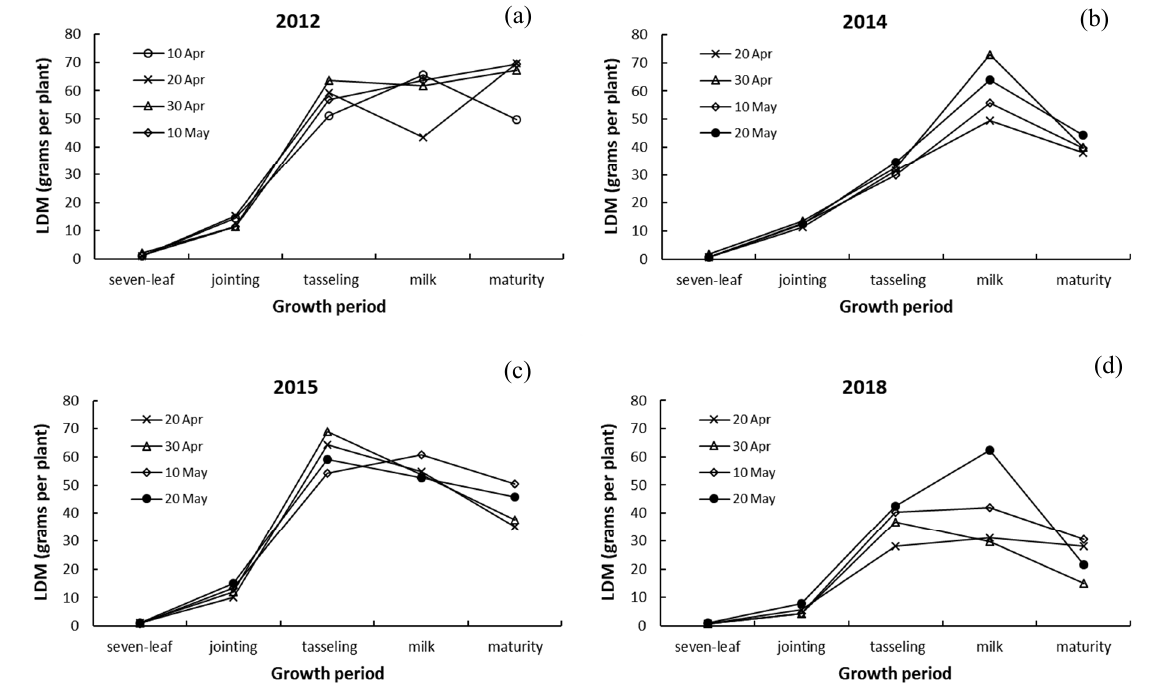
Figure 5. LDMs at different growth stages of maize sown on different dates: ( a ) 2012, ( b ) 2014, ( c ) 2015, ( d ) 2018.